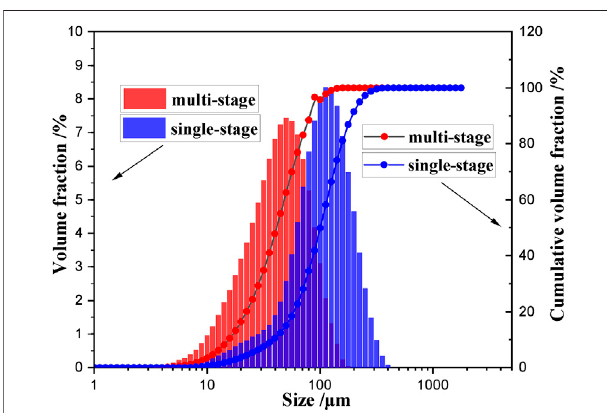
FIGURE 2 | Particle size curves of 304 stainless steel